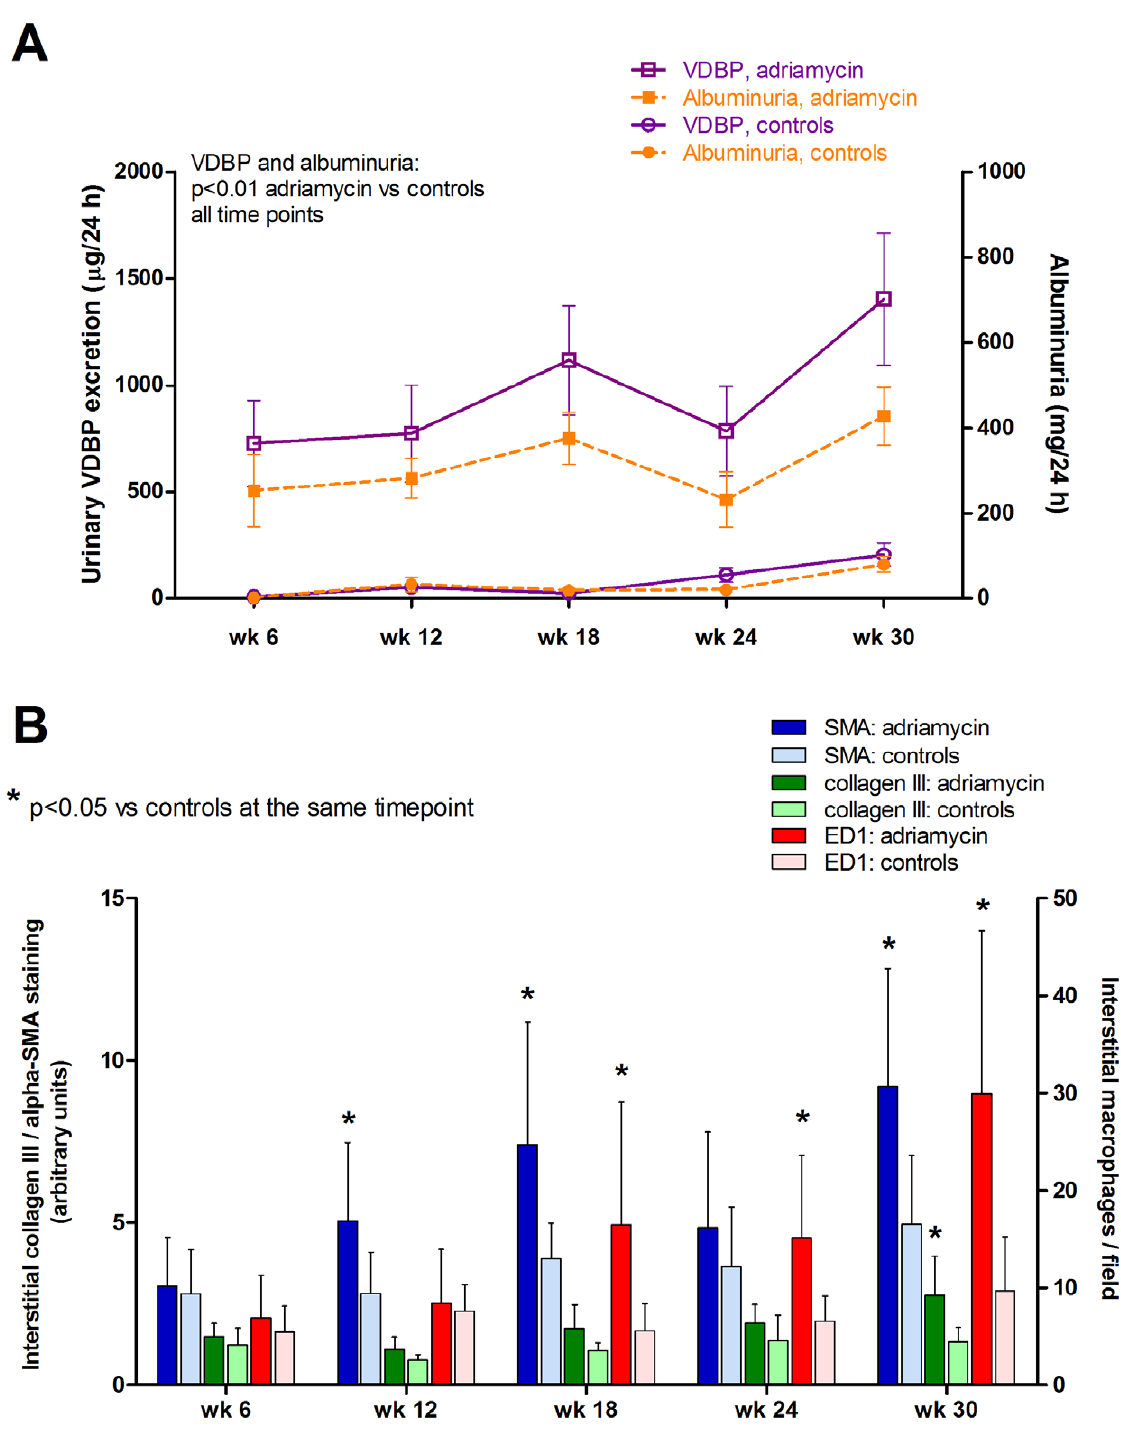
Figure 1. Urinary vitamin D binding protein (uVDBP) and albuminuria levels, and structural renal changes over time in adriamycin and control rats. A. Graphs illustrating the development of albuminuria (orange) and uVDBP (purple) over time in the unilateral adriamycin nephropathy model and in sham-operated control animals. B. Development of tubulointerstitial damage as reflected by interstitial a -smooth muscle actin (blue bars) and collagen III staining (green bars), and interstitial macrophage accumulation (red bars) in adriamycin rats (dark bars) and controls (light bars).